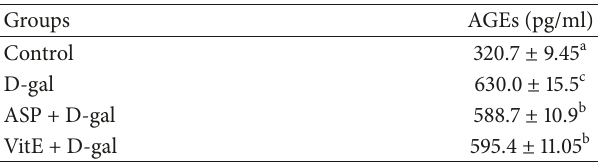
Table 1: Effect of ASP on the level of AGEs in serum of aging model